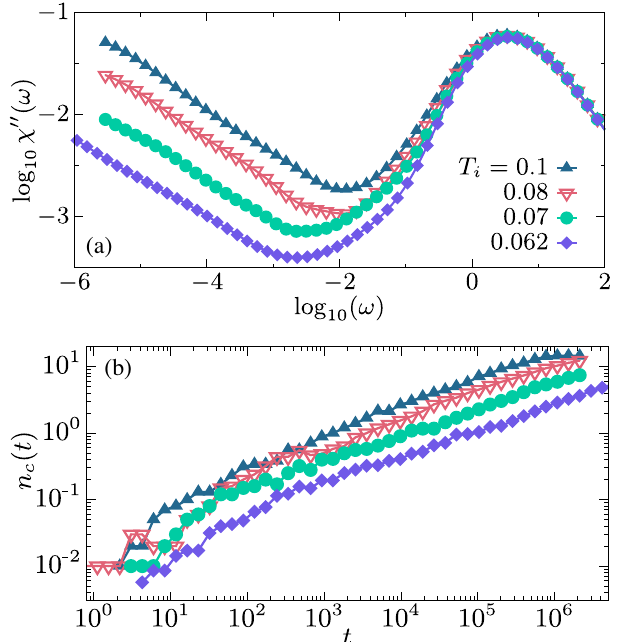
FIG. 12. Suppression of excess wings in ultrastable glasses in 3D. (a) Spectra χ 00 ð ω Þ measured at T ¼ 0 . 062 in glasses first equilibrated at T , then quenched at T ¼ 0 . 062 where they age i 2 × 10 6 . We report the equilibrium spectrum labeled during t w ¼ 0 . 062 . (b) Average number of clusters n by T i ¼ particles with the same definition as in Fig.